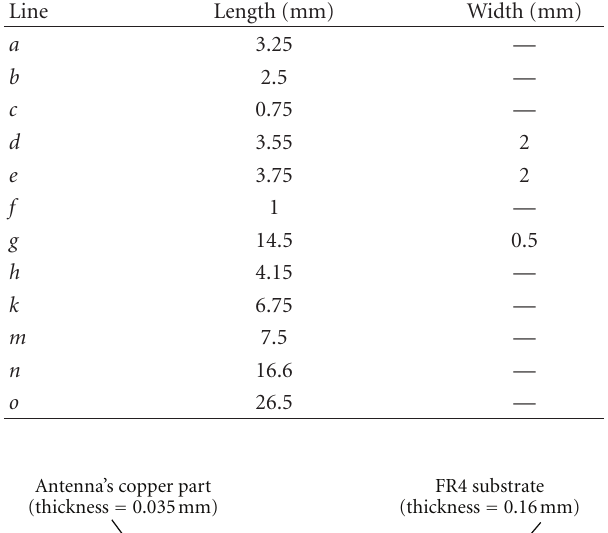
Table 1: Geometrical parameters of the tag.